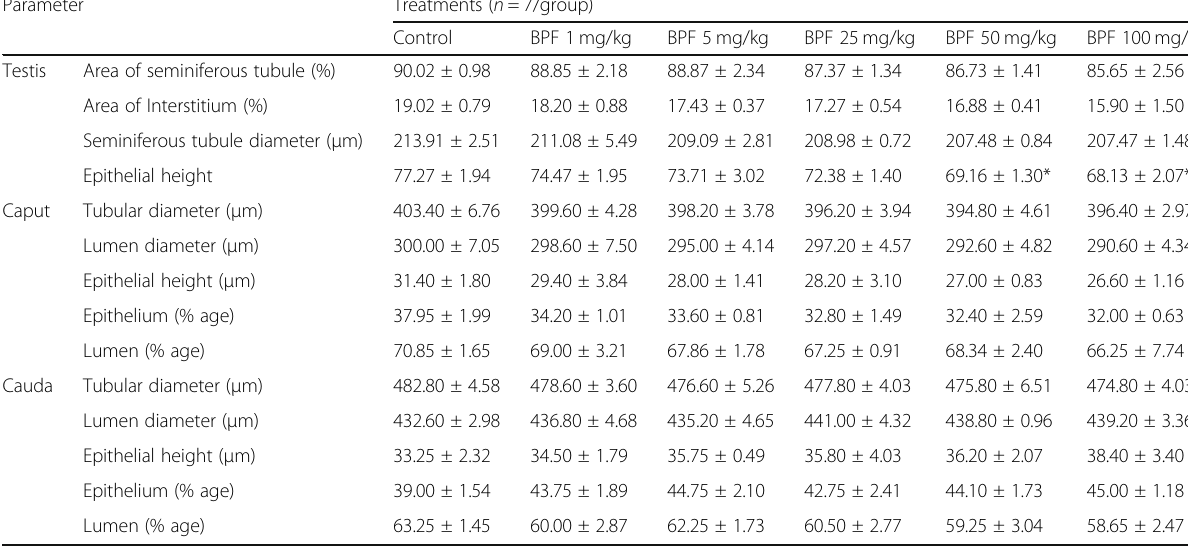
Table 4 Oral subchronically administered rats with Bisphenol F (BPF) testis, caput, and cauda epididymis morphometry after 28 days of exposure